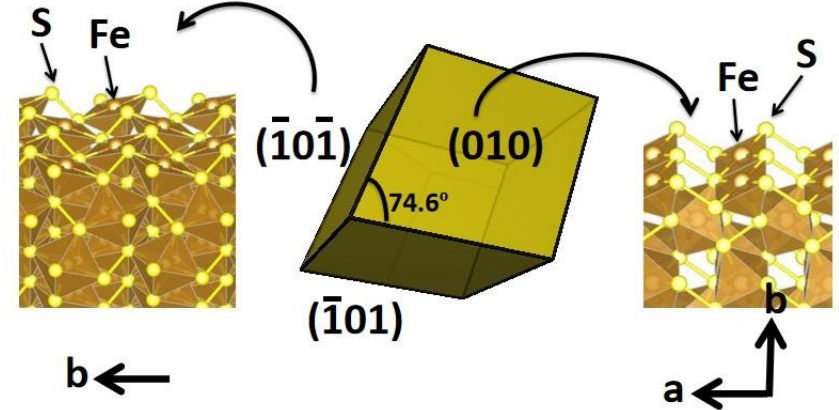
Figure 2. Simulated morphology using the Gibbs-Curie-Wulff construction from optimized surface energies with force field methods. Polyhedral representation (Fe: brown spheres inside polyhedra, S: yellow spheres).